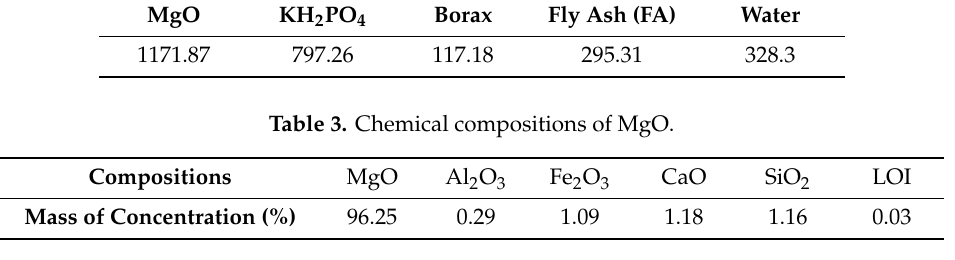
Table 4. Chemical compositions of fly ash (FA).